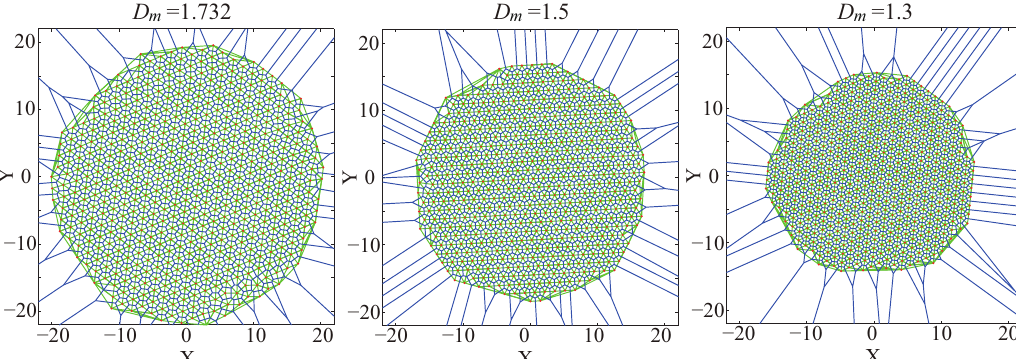
Figure 1. Final node distributions by the VFA-SF for indicated node equilibrium distance D m = 1.732, 1.5, and 1.3, respectively. Corresponding coverage area by these 500 nodes is 1299, 974.1 and 732,